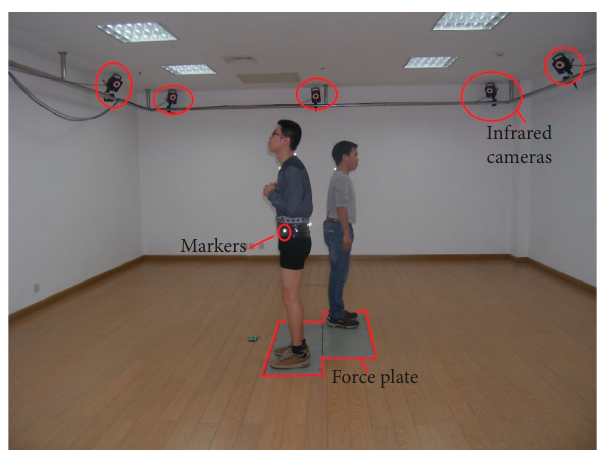
Figure 1: Gait analysis laboratory of Shuguang